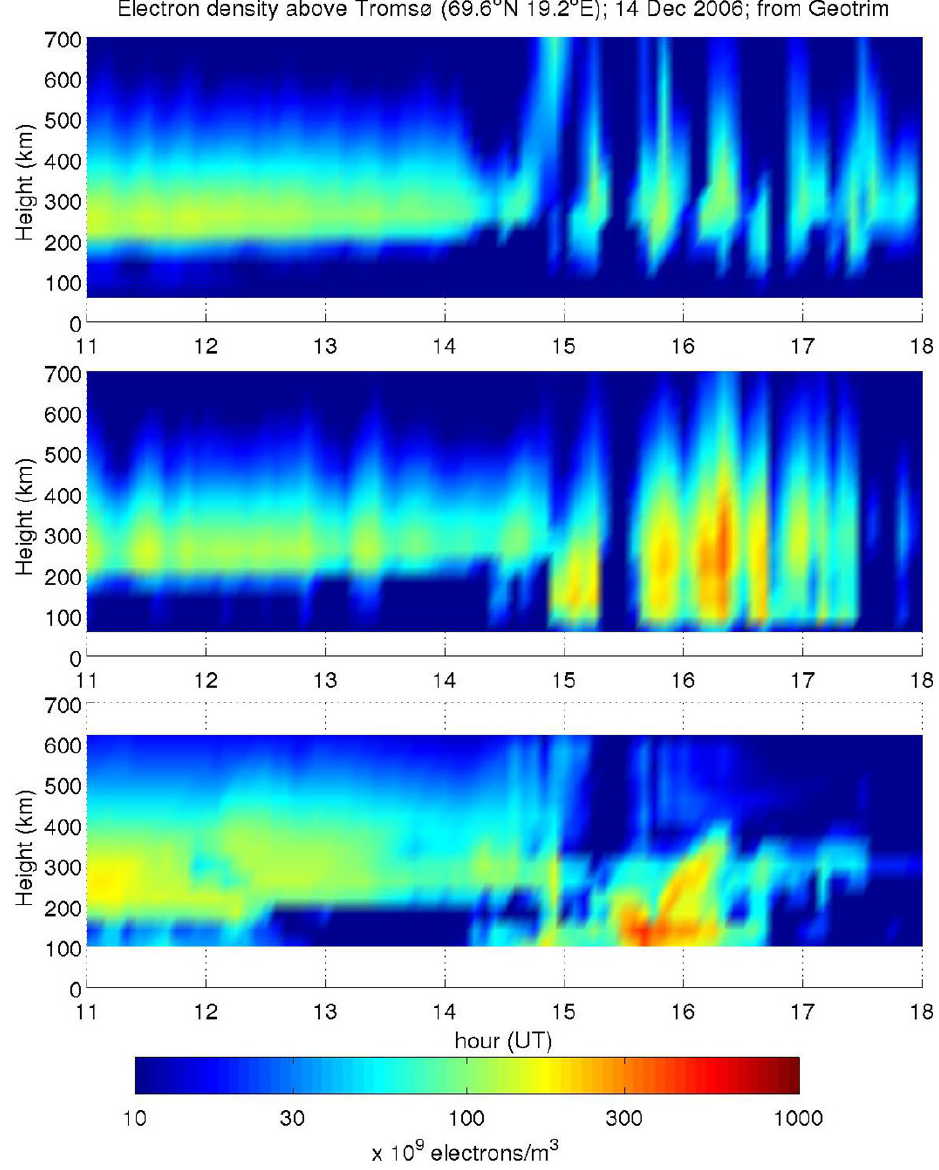
Fig. 9. Inversion result on December 14 above Tromsø (69.59 ◦ N; 19.23 ◦ E). Upper: method A, using the orthogonal functions from Chapman profiles. Middle: method B, using the orthogonal functions from the EISCAT measured profiles. Lower: method C, without using any vertical profile